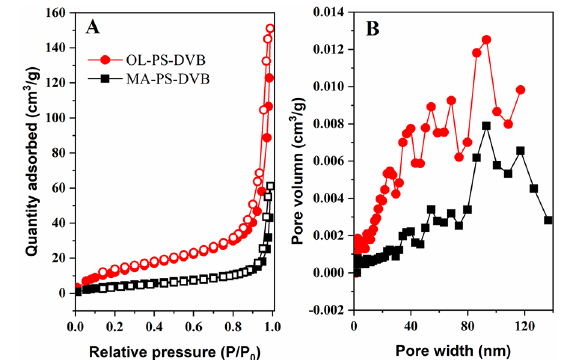
Fig. 3 Adsorption (filled) and desorption (empty) isotherms of N 2 at 77 K for synthesized OL‑PS‑DVB and MA‑PS‑DVB ( A ); Pore size distribution curves of OL‑PS‑DVB and MA‑PS‑DVB ( B